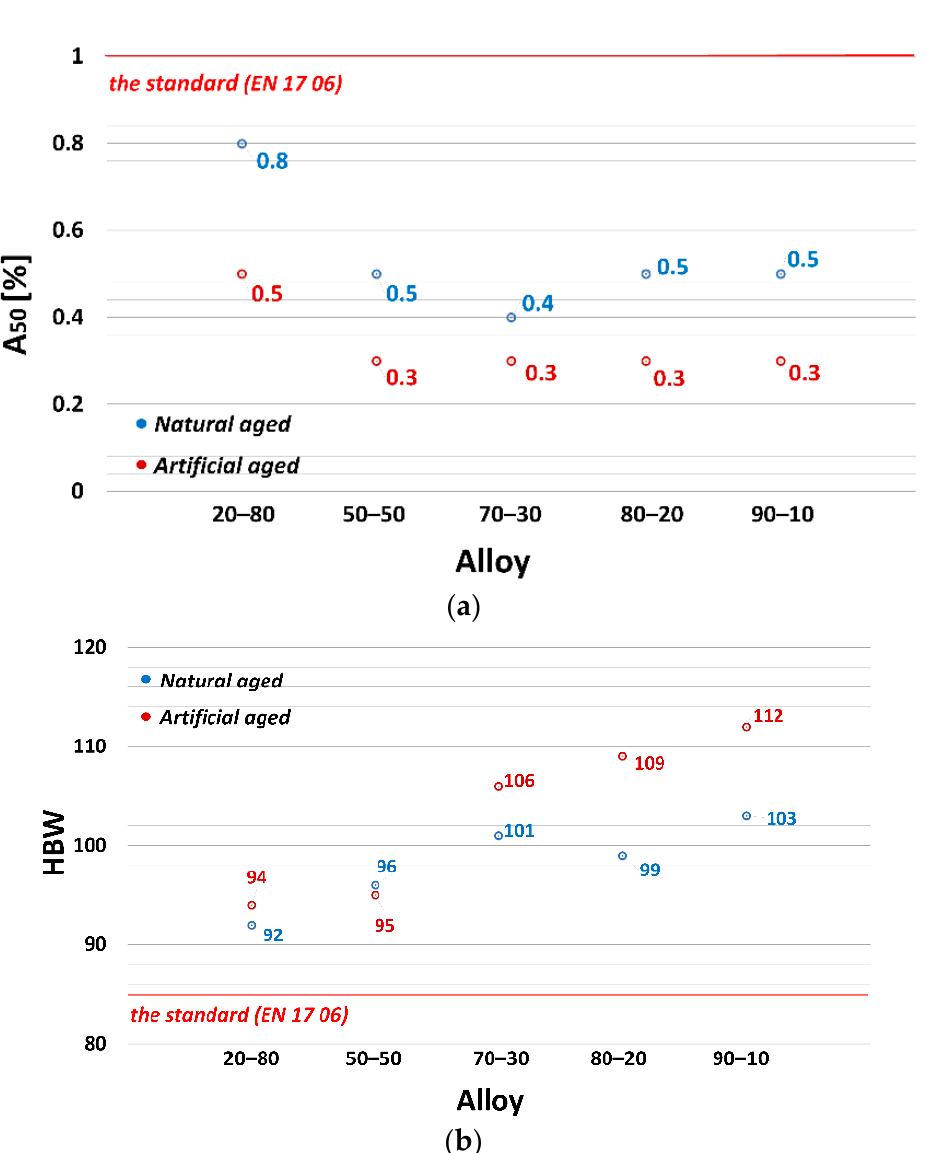
Figure 3. Relationship between: ( a ) Elongation; ( b ) Brinell hardness and experimental alloy and the state the alloy.